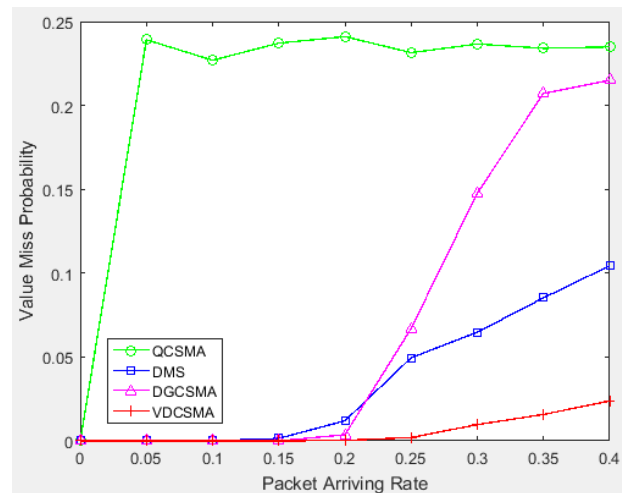
Figure 8. Value missing probability of real-time links: λ ∈ [ 0,0.4 ]